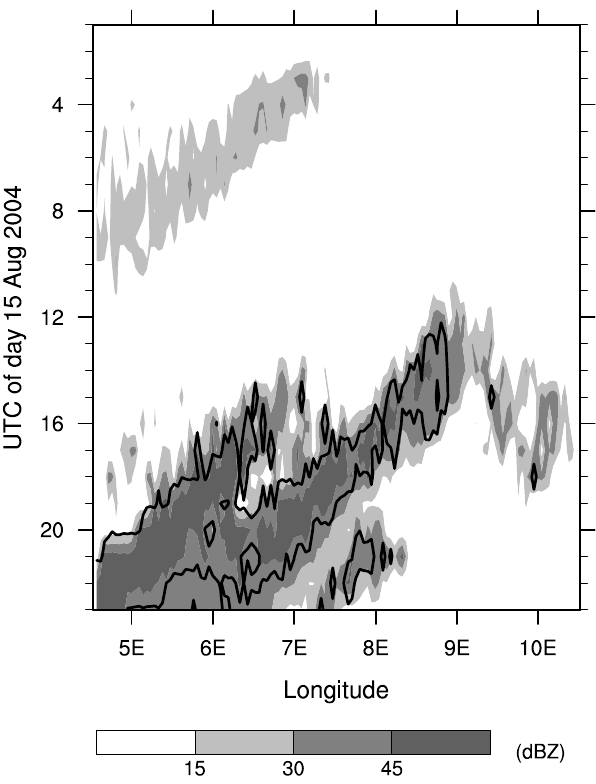
Fig. 4. Hovm¨oller plots from 15 August 2004 00:00UTC to 16 Au- gust 2004 11:00UTC of the maximum radar reflectivity (dBZ) in a grid cell column simulated by Meso-NH (grey areas). The black line shows the 5mmh − 1 instantaneous precipitation